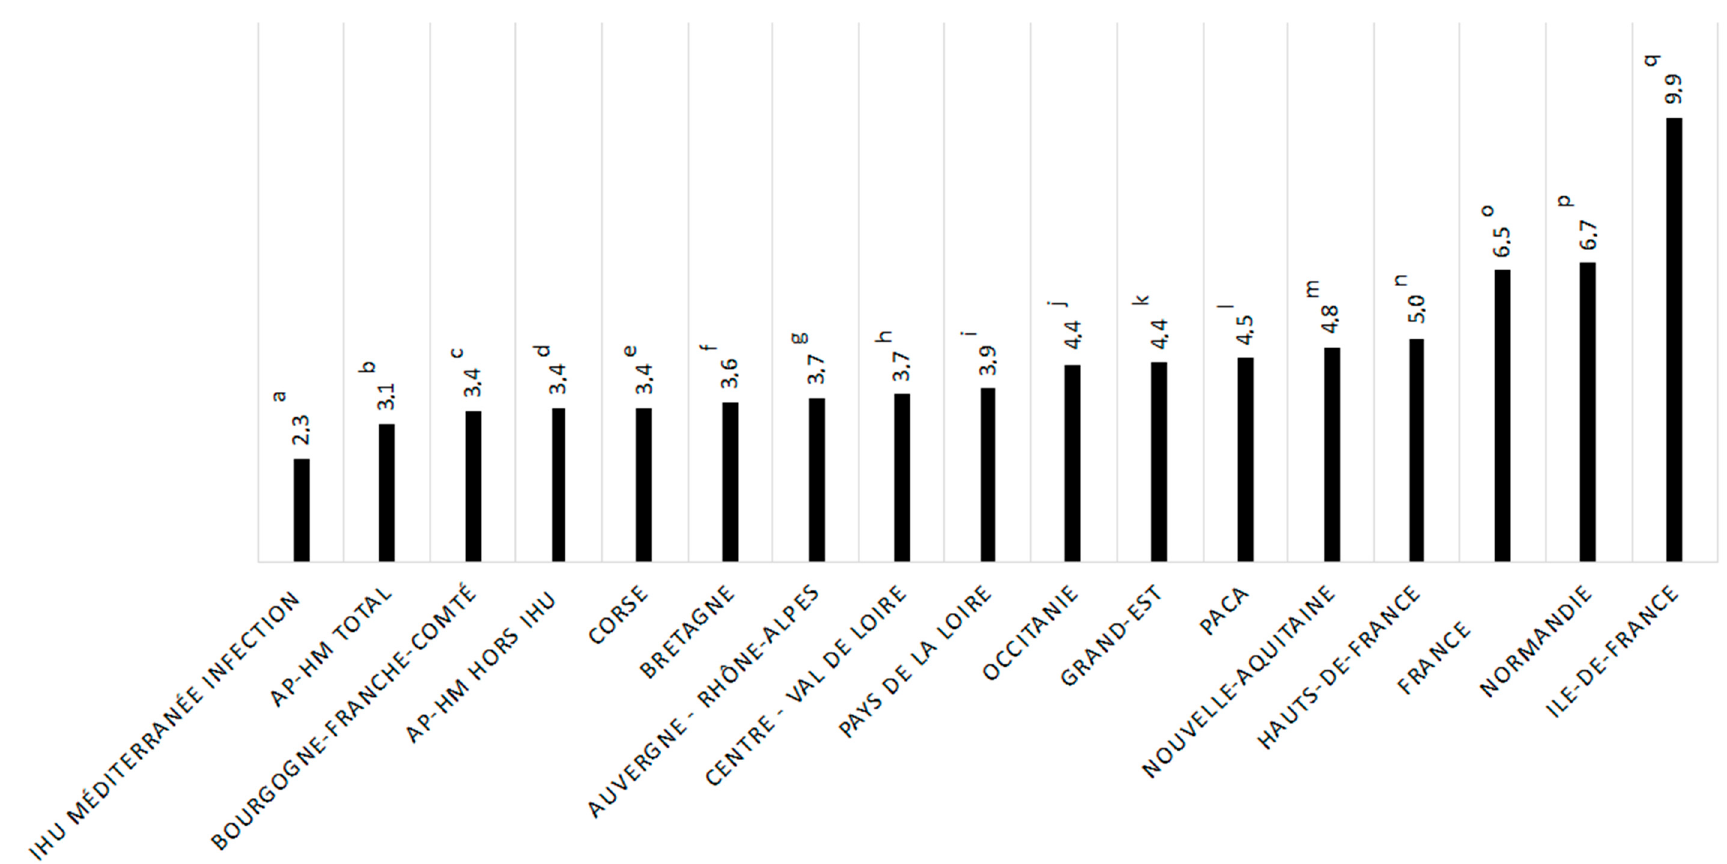
Figure 3. Comparison of mortality associated with COVID-19 in patients under 60 years of age at IHU M é diterran é e Infection, at AP-HM, in French regions and in France overall. For comparing the mortality in patients under 60 years of age between regions, a statistical test was done: q vs. k, p -value < 0.001, q vs. i, p -value < 0.001, q vs. g, p -value < 0.001, q vs. b, p -value = 0.007, q vs. o, p -value < 0.001. a , IHU M é diterran é e Infection; b , AP-HM total; c , Bourgogne–Franche-Comt é ; d , AP-HM without IHU; e , Corse; f , Bretagne; g , Auvergen–Rh ô ne-Alpes; h , Centre–Val de Loire; i , Paus de la Loire; j , Occitanie; k , Grand-Est; l , PACA; m , Nouvelle-Aquitaine; n , Hauts-de-France; o , France; p , Normandie; q , Ile-de-France.